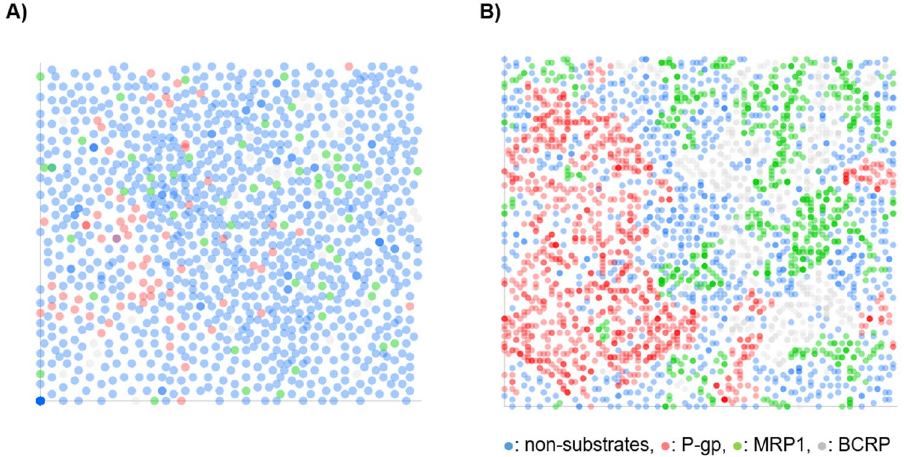
Figure 5. SOM projection of the original data set using ChemGPS descriptors ( A ) in contrast to the SMOTE data set ( B ) on 100 × 100 SOM with a variable adaptation radius from 10 to 1 in 100 iterations.